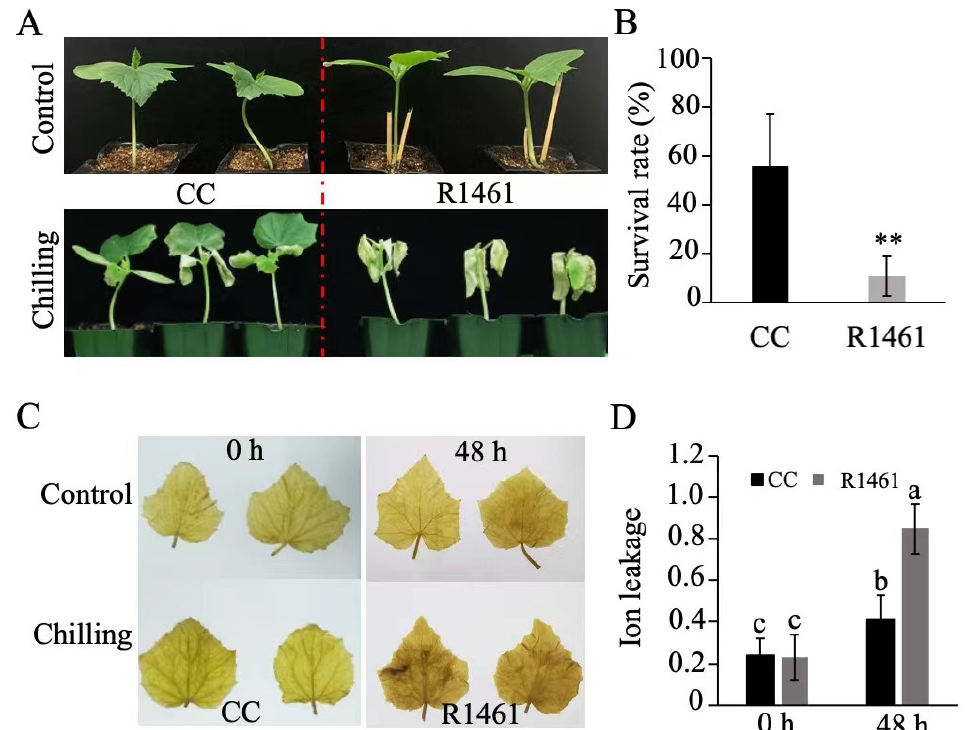
Figure 1. Effects of chilling treatment on CC and R1461. ( A ) Morphological phenotypes of CC and R1461 inbred lines before and after 4 days of chilling treatment. ( B ) Survival rate (%) of CC and R1461 inbred lines after 4 days of chilling treatment. Data are the means ± SD of three biological replicates consisting of 30 seedlings each. ** means p < 0.01, Student’s t -test. ( C ) DAB staining. ( D ) ion leakage before and after 48 h chilling treatment. Data are the means ± SD of three biological replicates consisting of 30 seedlings each. Different letters above the bars indicate significant differences among samples as determined by a one ‐ way ANOVA/Duncan ( p < 0.05).